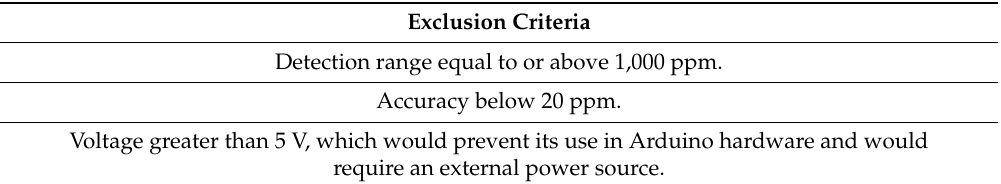
Table 2. Exclusion criteria of the sensors selected.